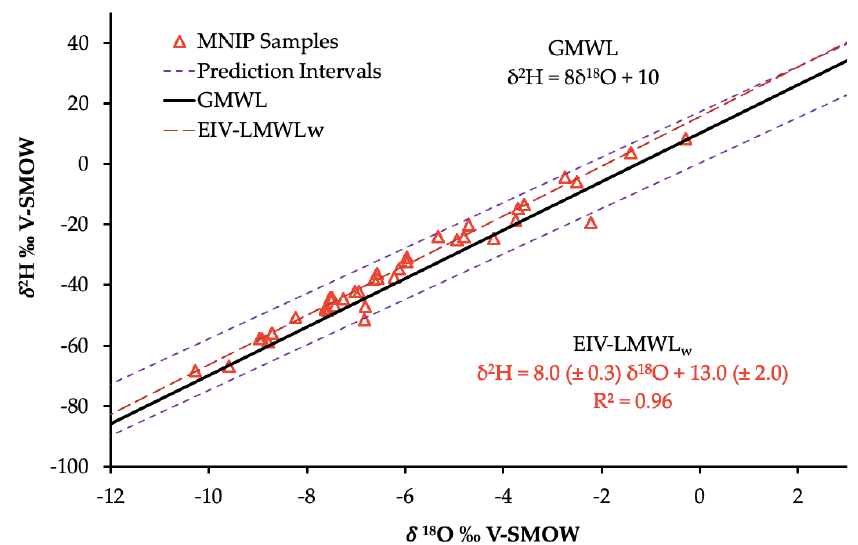
Figure 3. Monthly precipitation stable-isotope data for MNIP stations ( n = 37). Error–in–variables local meteoric water line (EIV–LMWLw) represents the weighted local meteoric water line for Ma–lawi (calculated based on error–in–variables regression analysis). MNIP: Malawi network of iso–topes in precipitation; GMWL: Global Meteoric Water Line.